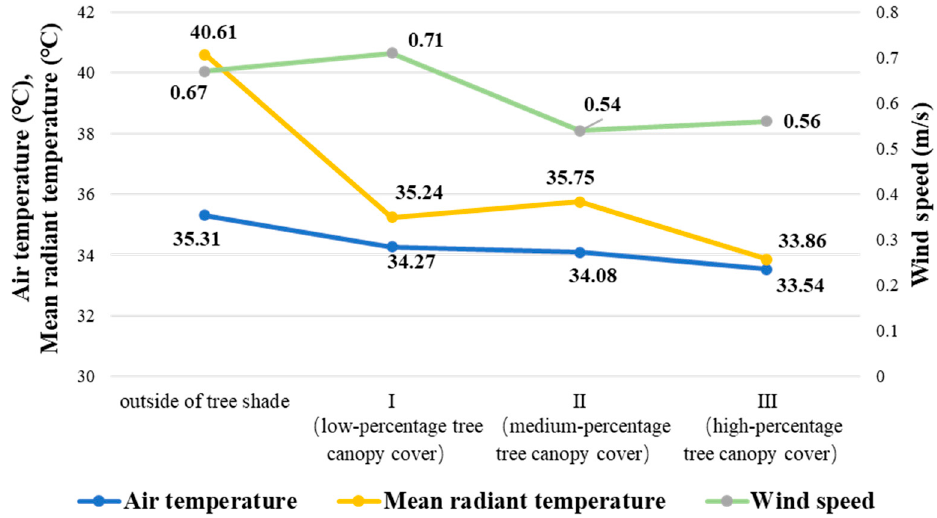
Figure 9. Mean values of air temperature, wind speed and radiation temperature under different degrees of tree canopy cover during the three questionnaire periods (morning 8:00–10:00, afternoon 12:00–14:00 and evening 19:00–21:00).